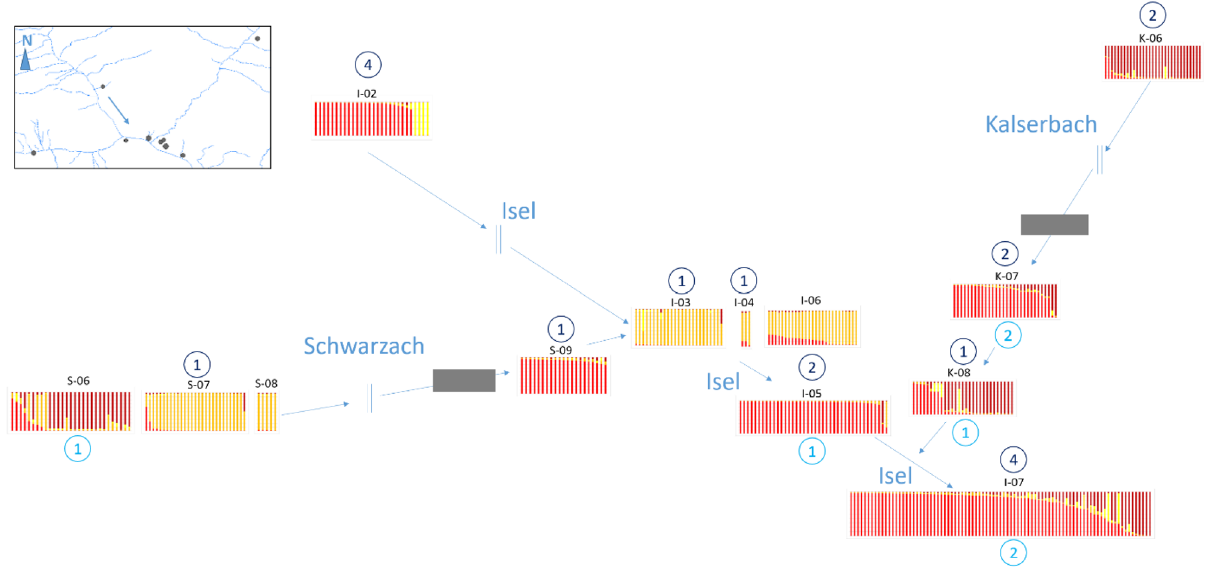
Figure 3. Genetic structure and number of migrants at the junction of Schwarzach (left), Kalserbach (right) and Isel (center) along the rivers (blue lines). The four genotype groups are represented in different colours (red, orange, yellow and brown) and number of immigrants from a source upstream (dark blue) and downstream (light blue) are shown in circles. Although two sites (one at Schwarzach and one at Kalserbach) are separated from the next source population upstream by canyons (grey blocks), they show immigrants from upstream. Geographically close populations next to the inlet of Kalserbach all show migrants from downstream